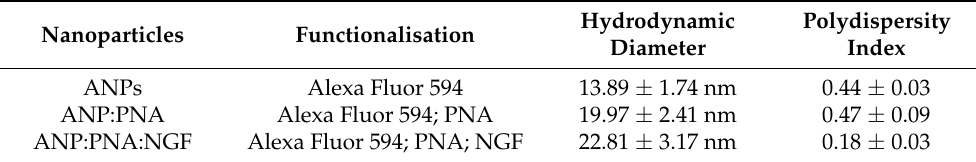
Table 1. Nanoparticle characterisation. Hydrodynamic diameter and polydispersity index of naked and functionalised polyacrylamide nanoparticles. Mean ± SEM, n = 3.